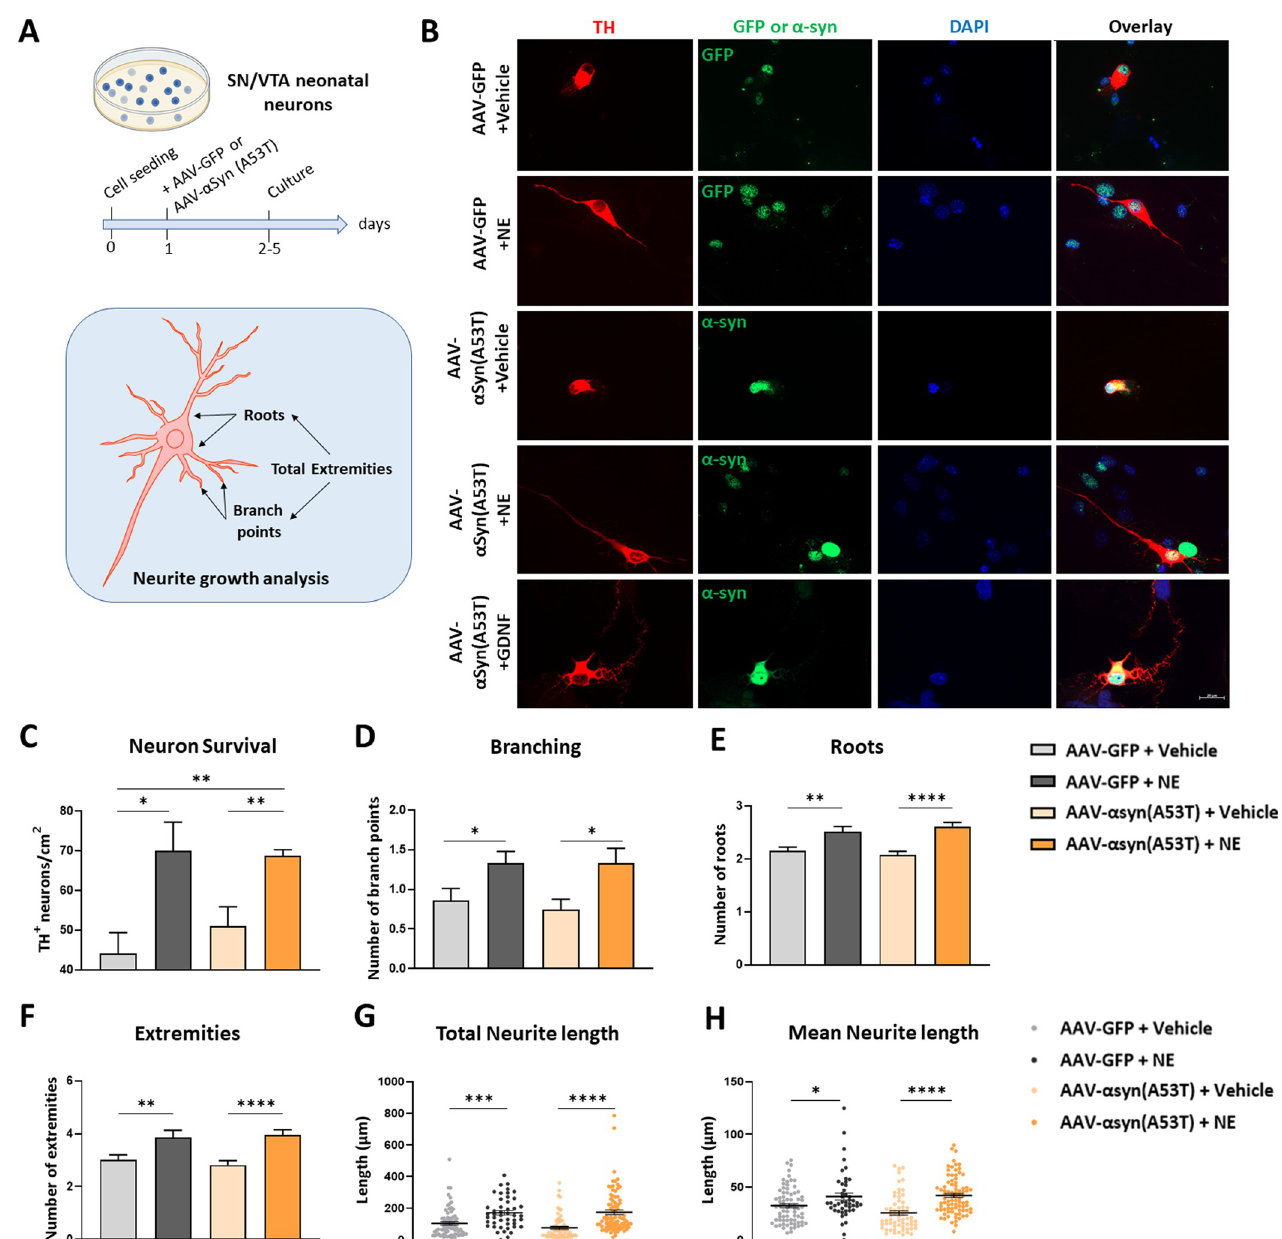
Fig 6. Neuroprotective role of NE in AAV- α -synuclein transduced primary DA cell culture. A- Time line for primary mouse ventral midbrain dopaminergic neurons tissue culture and representation of neurite analysis showing examples of roots, branch points, and total extremities. B- Representative images of dopaminergic neurons infected with AAV-hSynA53T α -synuclein or AAV-GFP, supplemented with vehicle, NE, or GDNF and immunostained with TH (red), GFP (green) or α -synuclein (green) with DAPI nuclear stain (blue), scale bar 20 μ m. C- TH neurons survival. D-H- Neurite growth analysis quantifying branching, root number, extremities and neurite length. ���� p < 0.00001, ��� p < 0.0001, �� p < 0.001, � p < 0.05, all values denote means ± SEM. https://doi.org/10.1371/journal.pone.0263074.g006 branch points (F = 4.621 p = 0.0036), roots (F = 11.33, p < .0001), extremities (F (3, 295) (3, 295) = 8.931, p < .0001) and neuronal length (F = 12.04, p < .0001) (Fig 6D–6H) in all (3, 295) (3, 278) DA neurons. The beneficial effect of NE was observed independently in both control (GFP) and A53T- α -syn expressing DA neurons. NE treatment provoked a gain in survival in neurons expressing A53T- α -syn, compared to vehicle or GDNF treatment (S7 Fig). Interestingly,